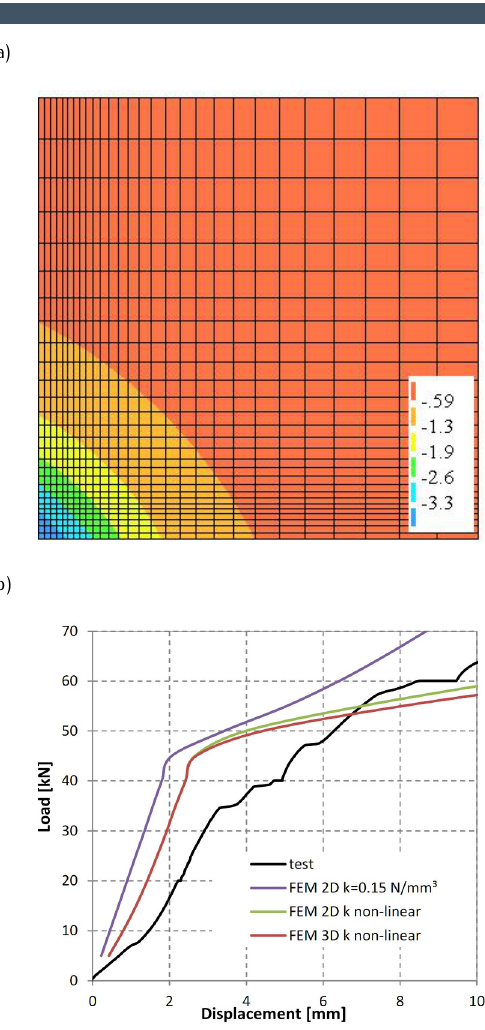
Figure 20. Corner load, (a) Crack pattern at top surface at 40 kN, (b) Distribution of stresses [N/mm 2 ] in the top layer of reinforcement at 40